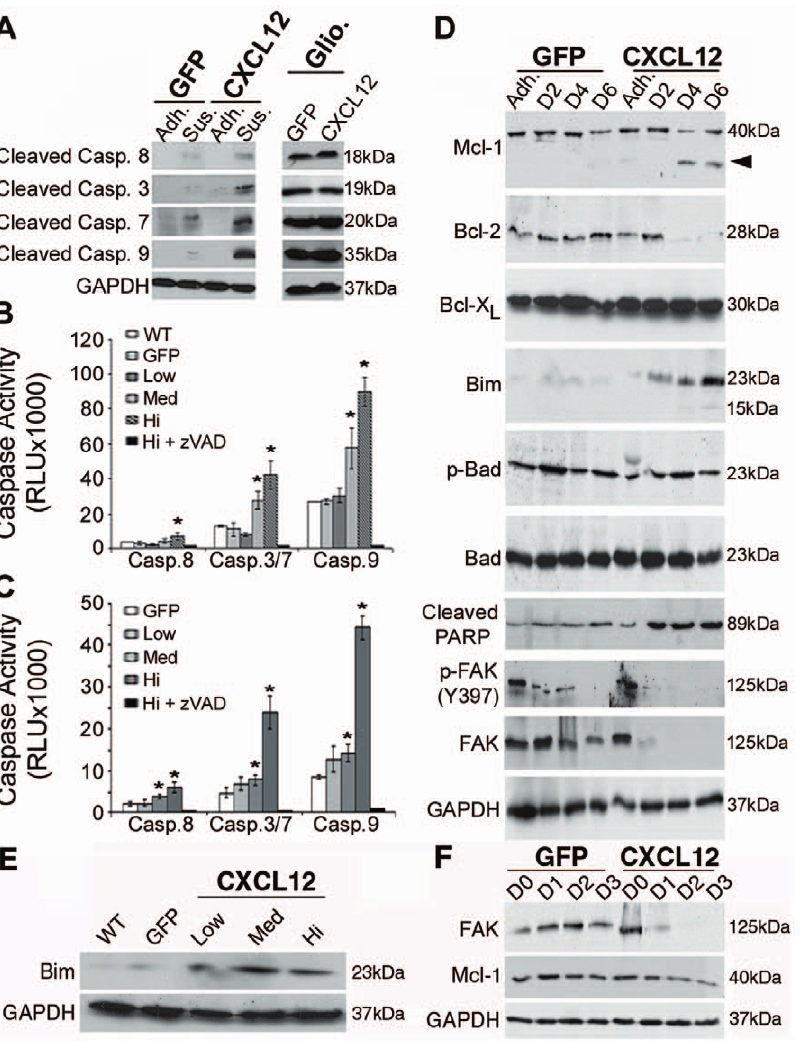
Figure 4. Constitutive CXCL12 expression induces anoikis through an intrinsic apoptotic mechanism. (A) CXCL12 and GFP HT29 cells were grown for 4-days as a suspension on poly-HEMA [10 mg/ml]-treated plates (Sus.) and whole cell lysates collected and compared to cells grown as an adherent monolayer (Adh.). Active cleaved caspase-8, -3, -7, and -9 indicated the predominant activation of an intrinsic apoptotic pathway in CXCL12 cells relative to control. Gliotoxin [2 m g/ml] confirmed intact apoptotic machinery in both cell lines. (B,C) Luminescence-based caspase activity assays were used to examine levels of both initiator caspases-8 and -9 and executioner caspases-3/7 after 4-days on poly-HEMA. Clonal HT29 (B) and HCT116 (C) cell lines expressing variable levels of CXCL12 (Hi, Med, Low) indicated a dose dependent effect of caspase activity which was inhibited with addition of zVAD. Values are mean 6 SD of 3 independent experiments completed in triplicate. (D) GFP and CXCL12 HT29 cells were cultured on poly-HEMA-treated plates and lysates collected over time. Immunoblot analysis revealed a decrease in Mcl-1 and Bcl-2 levels and an increase in Bim in CXCL12-expressing cells. Arrowhead indicates a lower molecular weight protein consistent with an Mcl-1 degradation product. (E) HT29 cells expressing variable levels of CXCL12 exhibit increased Bim expression after a 4-day culture on poly-HEMA. (F) Immunoblot analysis of adherent HT29 cells demonstrate the temporal loss of FAK activation precedes decreased Mcl-1 levels in CXCL12-expressing cells cultured as an adherent monolayer on tissue culture plastic. Data are representative of three independent experiments. * indicates statistically significant